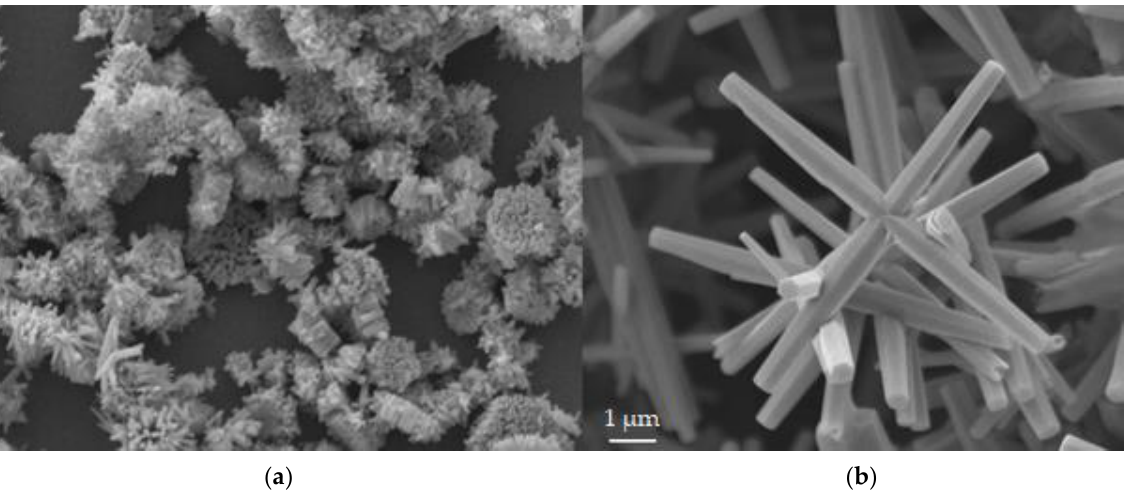
Figure 2. ( a ) SEM image for sample 1; ( b ) SEM image for and sample 2, for ZnO rods grown on ITO. Sample 1 shows bundles of small rods. Sample 2 yields a combination of larger rods and “nanoflowers”. Both Images are at the same scale.